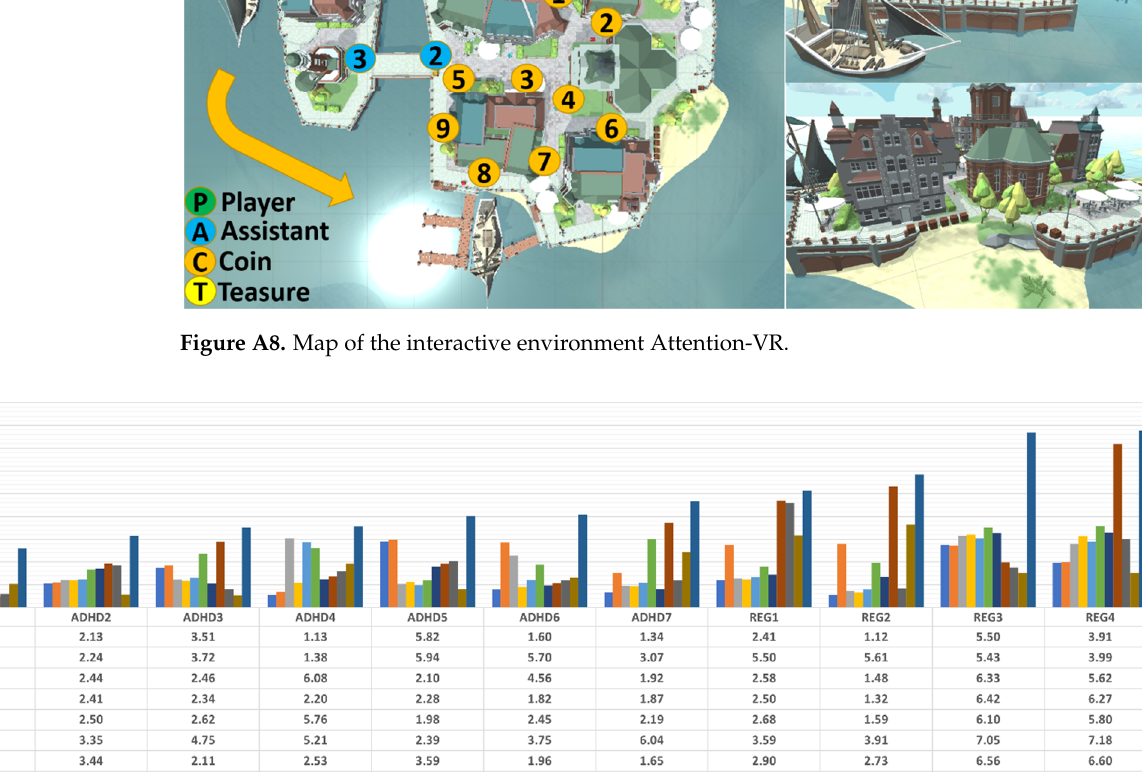
Figure A9. Time in minutes by children to solve Attention-VR, performance data obtained from the Firebase database.